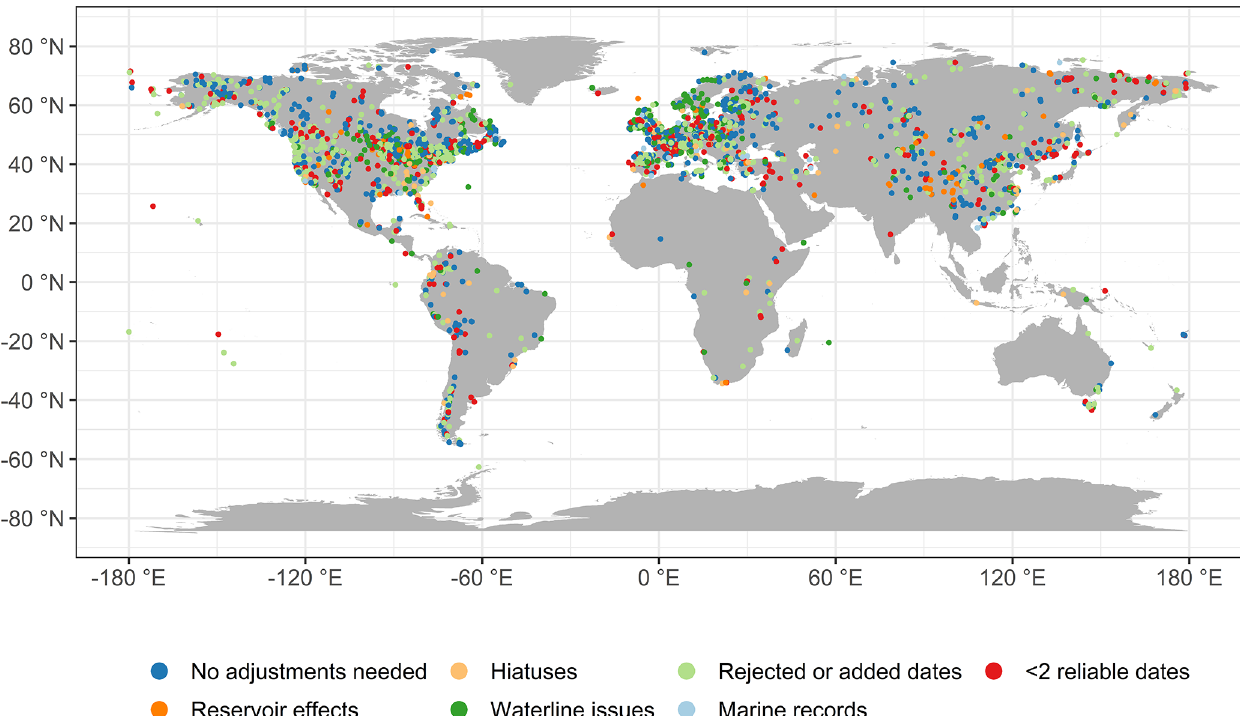
Figure 2. The distribution of records that faced various major challenges when establishing their chronologies.